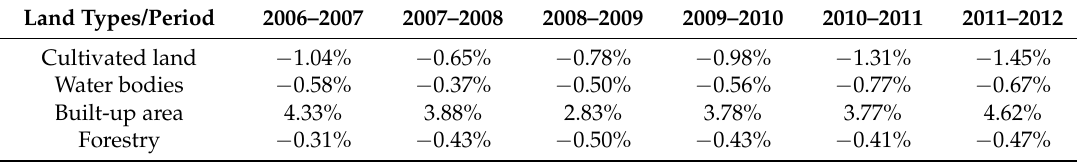
Table 3. Land use integrated dynamic degree (Rt) in Wuhan from 2006 to 2012.